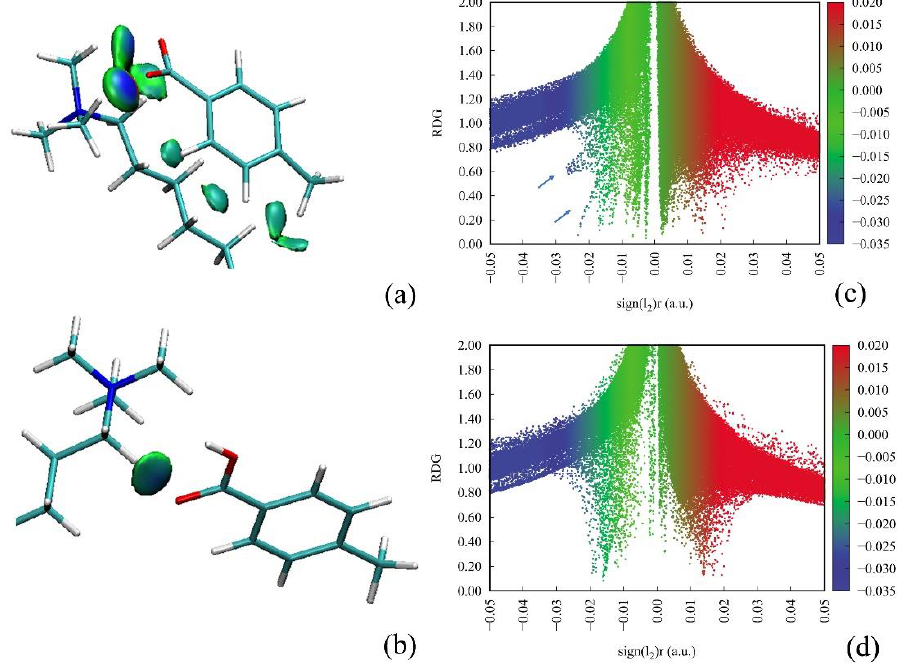
Figure 5. Weak interaction analysis for ( a ) PTA − /CTA + and ( b ) PTA/CTA + . Insets ( c , d ) show the reduced density gradient (RDG) versus electron density for configurations shown in insets a and b, respectively.